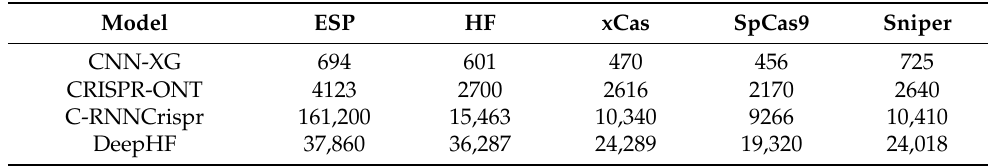
Table 8. Overall training time cost comparison of CNN-XG, CRISPR-ONT, C-RNNCrispr and DeepHF on five datasets under 10-fold